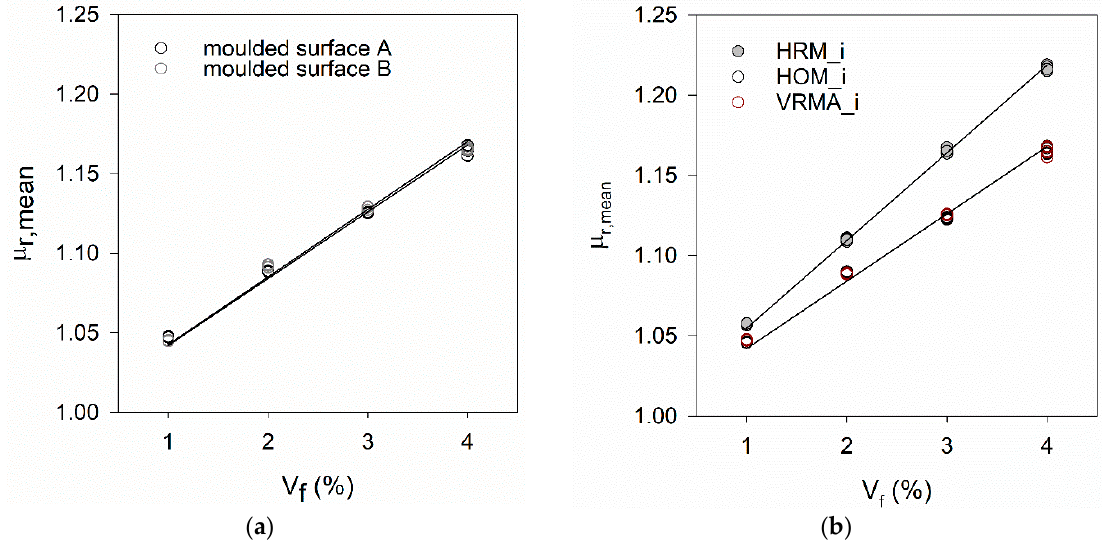
Figure 16. Increase of μ r,mean results as a function of V f and corresponding fitting lines for ( a ) VR_i specimens ( b ) all moulded surfaces.